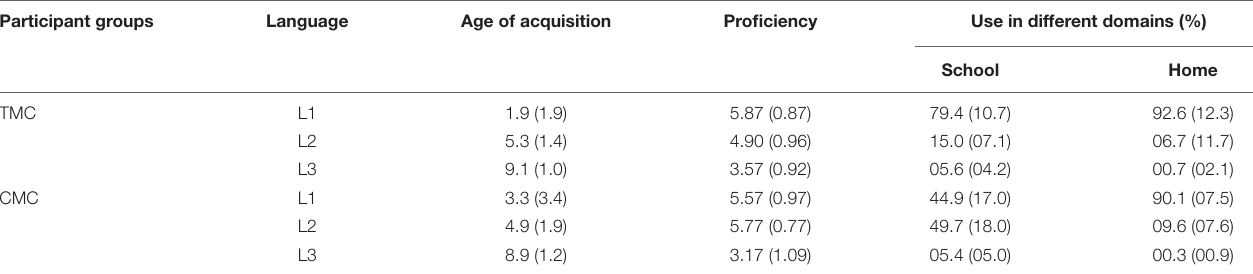
TABLE 1 | Language history information (mean and standard deviation) of the participants.